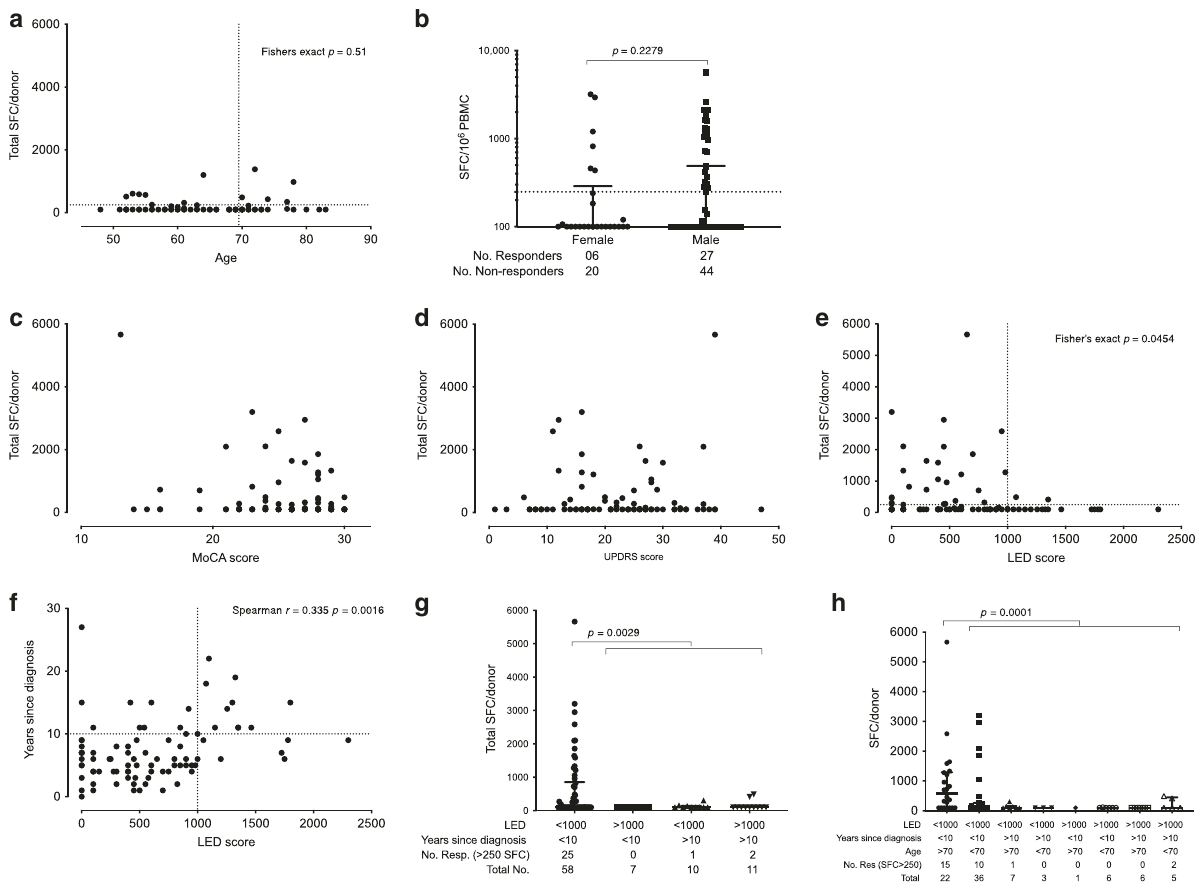
Fig. 6 Correlation between α -syn-speci fi c T cell reactivity and clinical variables. a Age ( n = 97): dotted lines indicate 250 SFC and 70-year-old cut-off for two-tailed Fisher ’ s exact test. b Frequency and magnitude of T cell responses in males ( n = 71) and females ( n = 26) with PD. The dotted line indicates 250 SFC for Fisher ’ s exact test. c MoCA score ( n = 85), d UPDRS score ( n = 85), and e LED score ( n = 86); dotted lines indicate 250 SFC and 1000 LED cut-off for two-tailed Fisher ’ s exact test. f Correlation between LED score and time since diagnosis ( n = 86); dotted lines indicate 10 years since diagnosis and 1000 LED cut-off for two-tailed Fisher ’ s exact test. Correlation is indicated by Spearman r and associated p value. g Segregation of subjects with PD in low (<1000) and high ( ≥ 1000) LED score with diagnosis <10 and ≥ 10 years ago. Number of data points per condition is indicated in the fi gure (Total No.). Two-tailed Fisher ’ s exact test comparing individuals with <1000 LED, <10 years ago since diagnosis and >250 SFC (left in graph) vs. the three other groups. h Segregation of subjects with PD based on LED score (cut-off 1000), years since diagnosis (cut-off 10) and age (cut-off 70). Two-tailed Fisher ’ s exact test comparing individuals with <1000 LED, <10 years ago since diagnosis, >70 years old, and >250 SFC (left in graph) vs. the seven other groups. Total number of PD responding to α -syn peptide pool ( n = 28). Total SFC is de fi ned as the magnitude of responses (sum of IFN γ , IL-5, and IL-10) against the α -syn peptide pool as SFC per 10 6 cultured PBMC. b , g , h Median ± interquartile range is